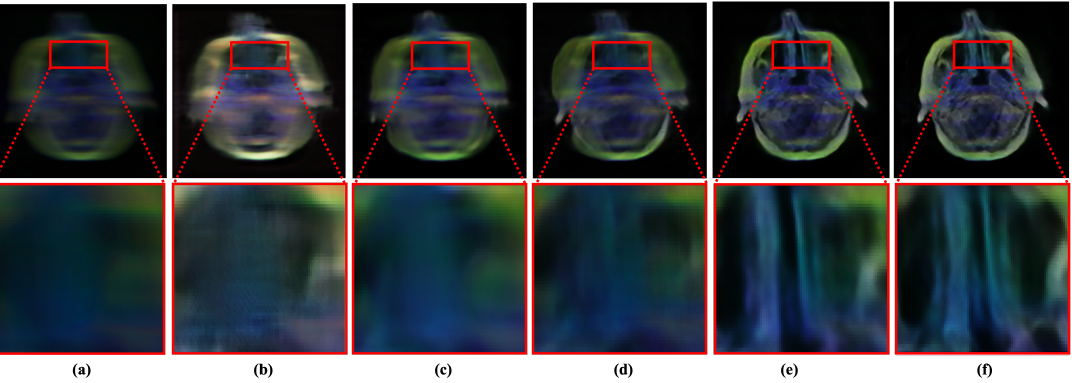
Figure 1. Performance of existing medical image deblurring methods in removing blind motion blur. The existing deblurring methods immensely failed in removing blur from medical images. ( a ) Blurry input. ( b ) Result obtained by TEMImageNet [9]. ( c ) Result obtained by ZhaoNet [11]. ( d ) Result obtained by Deep Deblur [12]. ( e ) Result obtained by SRN Deblur [13]. ( f ) Proposed